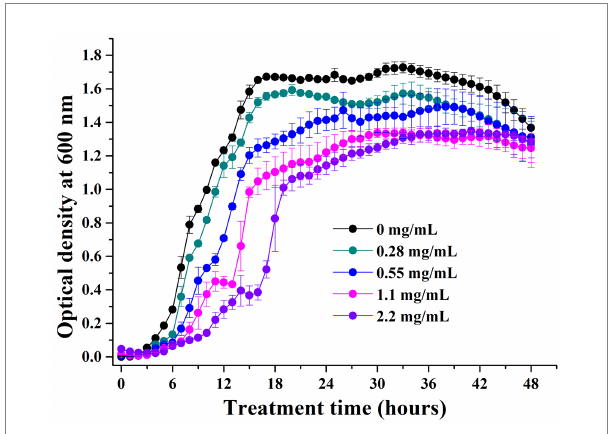
FIGURE 4 Growth curves of Pseudomonas aeruginosa PAO1 treated with different concentrations of geraniol.